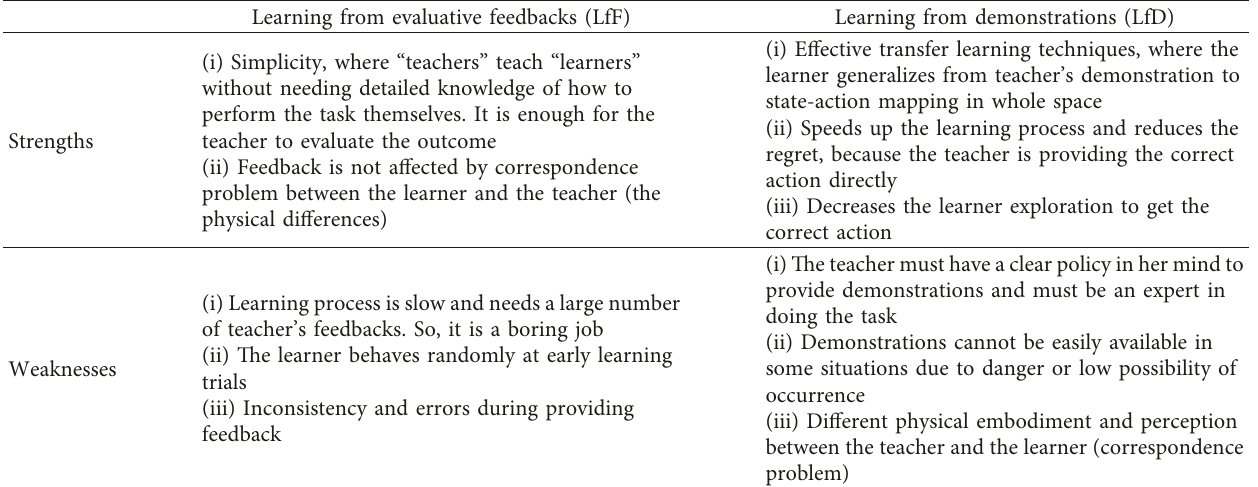
Table 1: Strengths and weaknesses of LfD and LfF